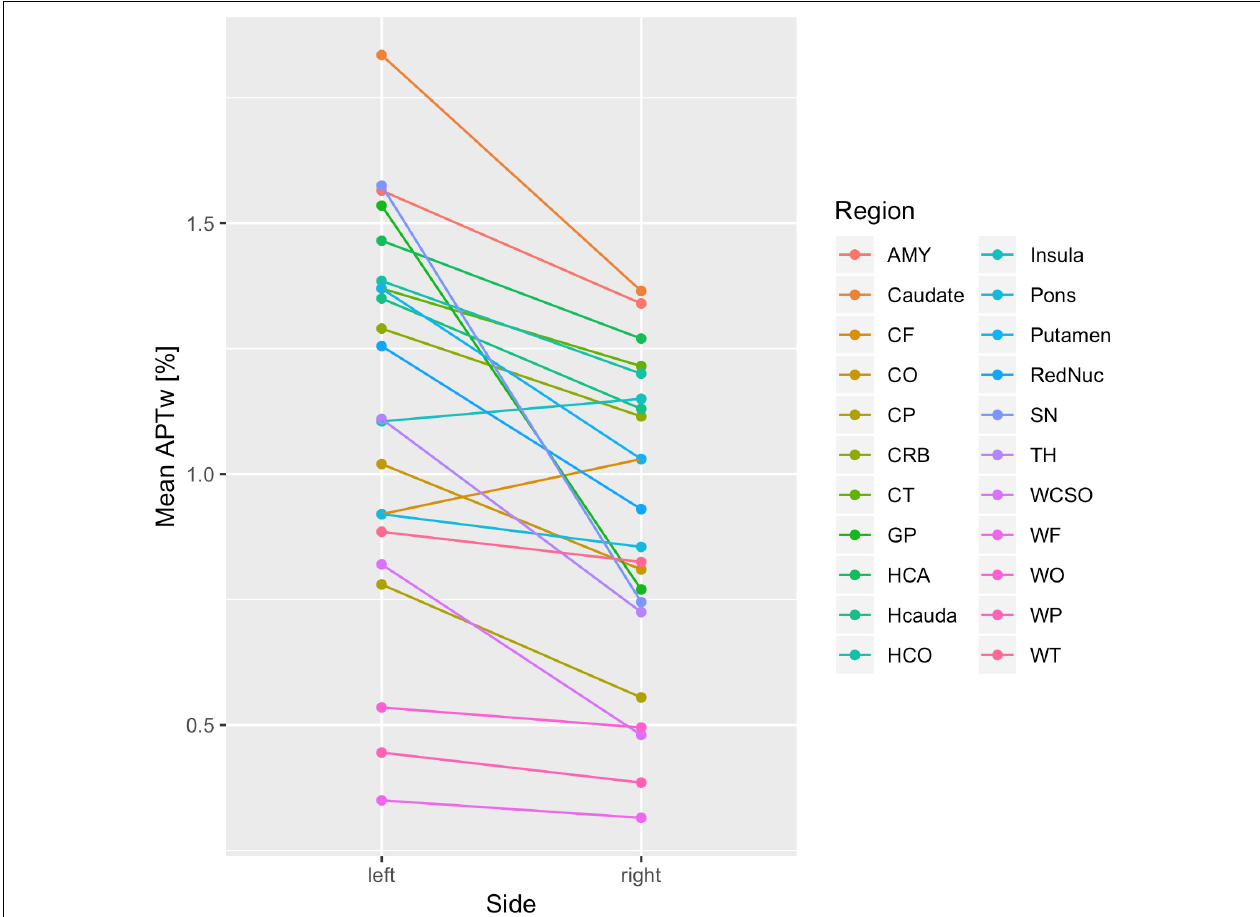
FIGURE 4 | Differences in Mean APTw intensity values between sides are